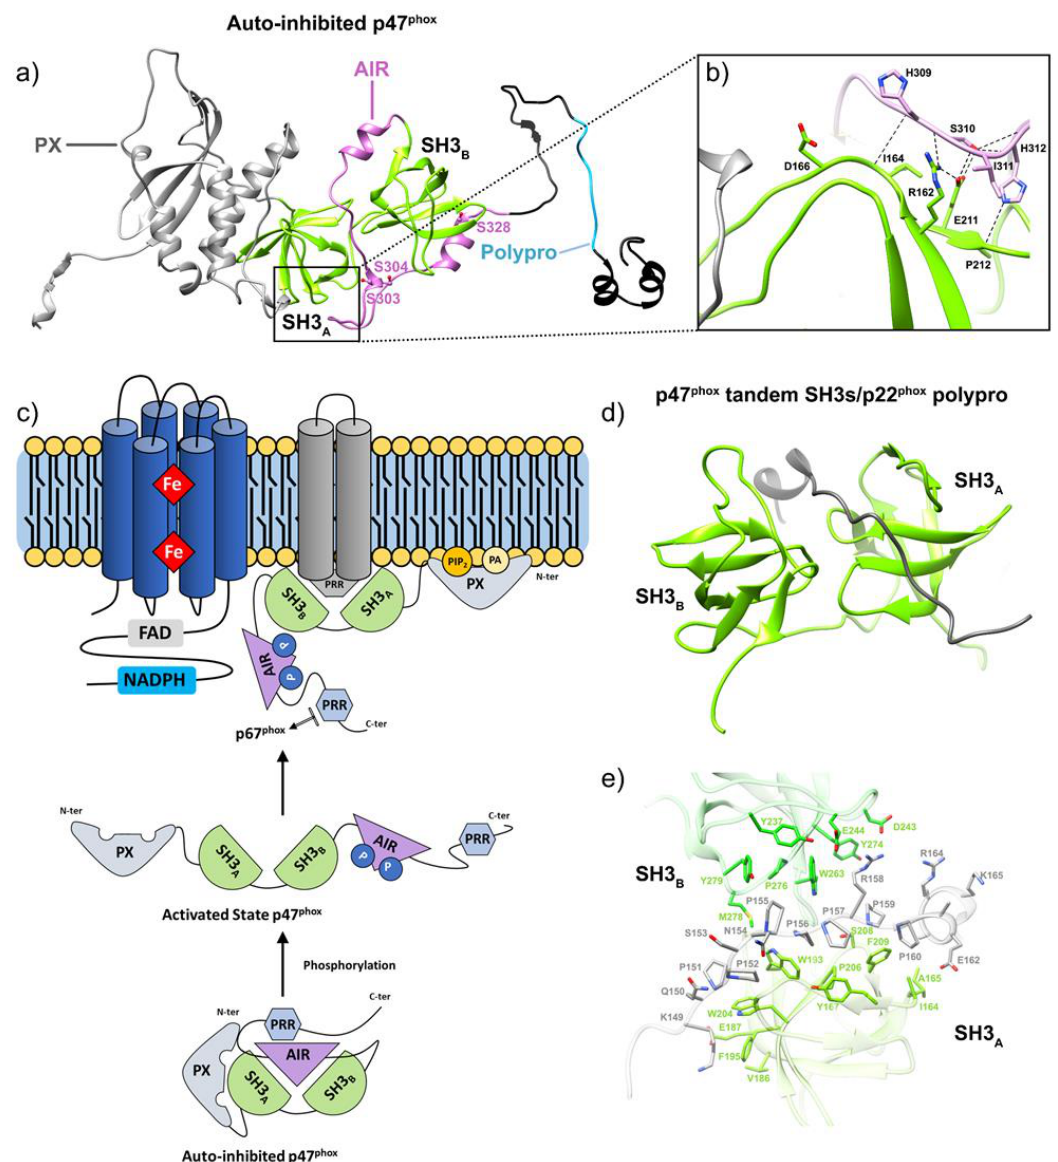
Figure 9. Model of the p47 phox activation mechanism showing the link between AIR and PX motif releases. ( a ) Model of the auto-inhibited p47 phox . This model results from the combination of SAXS and HDXMS characterization on whole p47 phox [59,61] and the insertion of the high-resolution structure of the individual domains: the PX domain (pdb: 1KQ6), autoinhibited tandem SH3, comprising the two SH3 domains locked by the AIR region (pdb: 1NG2) [55] and the polyPro of p47 phox from pdb:1K4U [54]. The PX domain is in gray, tandem SH3 in green, AIR sequence in pink and C-terminus in black, except for the polyPro motif in blue. The phosphorylation target sites involved in the activation of p47 phox (S303/S304/S328) are represented in ball and stick. ( b ) The insert provides a close-up showing the network of interactions maintaining PX/SH3 and AIR locked alto-gether. Polar interactions occur between residues Arg-162, Ile-164, Glu-211, and Pro-212 from SH3A (green) and residues His-309, Ser-310, Ile-311, and His-312 from AIR (pink). The docking site of the PX domain in the resting state as shown by its release upon mutation on residue 162 and 166 [61]. ( c ) Phosphorylation of the AIR domain leads to the release of the auto-inhibitory intramolecular interaction between the AIR domain and the bis-SH3 domain, leading to the release of the PX domain and the activation of p47 phox [61]. ( d ) Structure of p22 phox -p47 phox complex (pdb: 1WLP) solved by NMR [109]. The p47 phox tandem SH3s (aa 151–286) is represented in green ribbon and the p22 phox polyPro (aa 149–168) is represented in gray ribbon. This structure obtained with a truncated recombinant p47 phox bis-SH3 and p22 phox polyPro (residue 146–179) mimics the interaction between p47 phox and p22 phox following AIR release. ( e ) Recognition of p22 phox -(149–168) (in gray) by the SH3A and SH3B (in green) domains of p47 phox -(151–286). SH3A and SH3B (in green). The side chains of the amino acids involved in the recognition of p22 phox -(149–168) by the SH3A and SH3B domains are shown in the wire model and